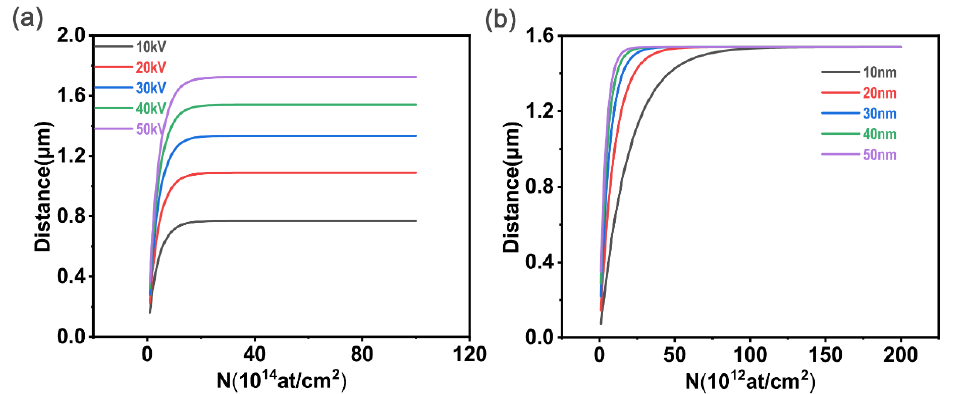
Figure 2. ( a ) r = 10 nm: the total penetration depth of the individual carbon black particle varies with the implantation dose. ( b ) U = 40 kV: the total penetration depth of the individual carbon black particle varies with the implantation dose.